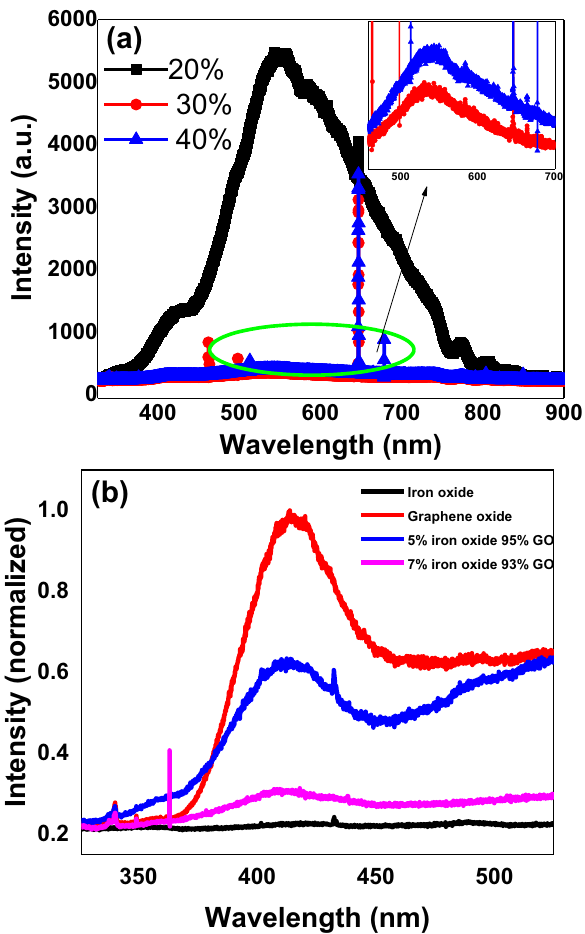
Figure 9. Photoluminescence (PL) spectra of ( a ) controlled oxidized GO nanosheets samples ( b ) Graphene oxide, Iron oxide nanoparticles and GO/Iron-oxide